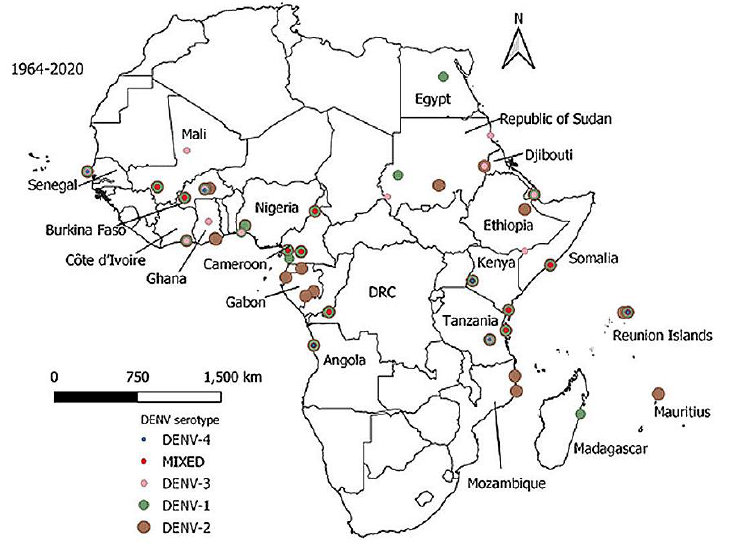
Figure 2. Distribution of dengue virus serotypes in Africa, 1964−2020. DENV-2 was the dominant serotype (brown), followed by DENV-1 (dark green), DENV-3 (light pink), Mixed serotypes (red) and DENV-4 (blue). The map was developed using Quantitative Geographic Information System (QGIS) open-source software version 3.16 available at https://www.qgis.org/en/site/forusers/download (accessed on 12 February 2021).